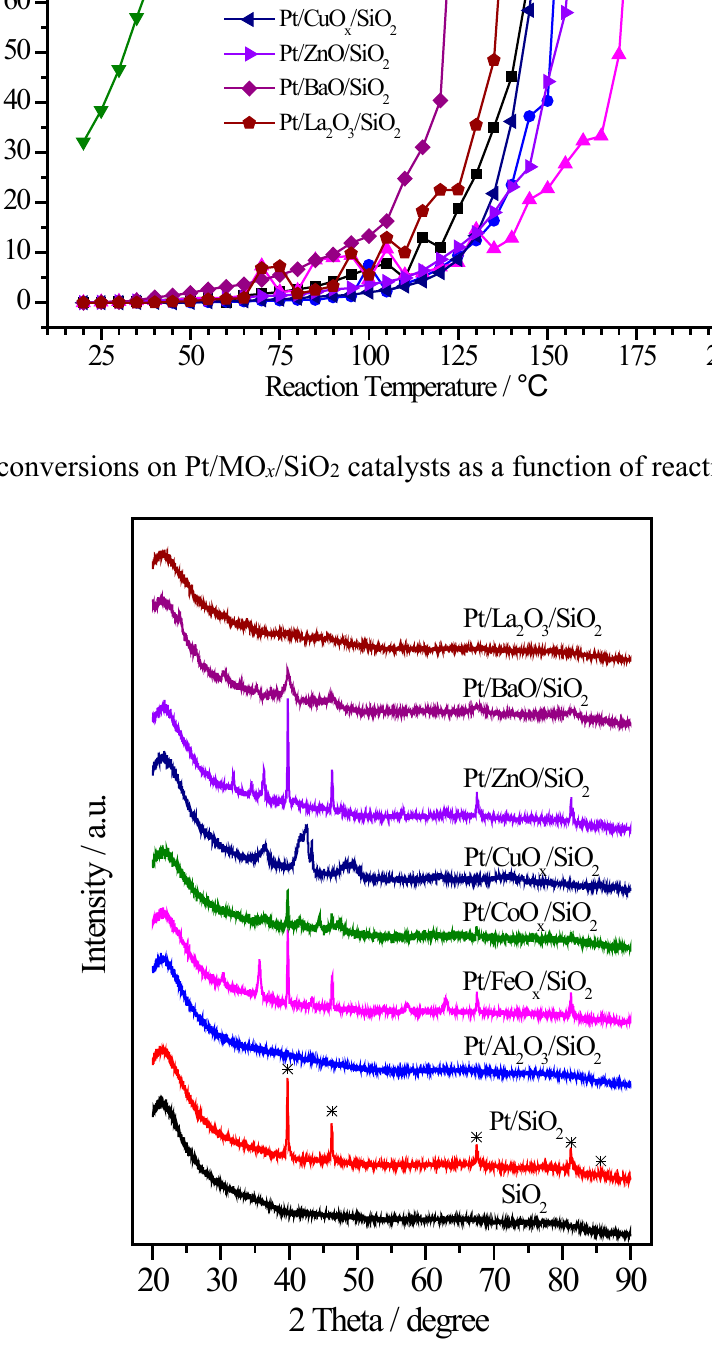
Figure 2. XRD patterns of Pt/MO x /SiO 2 catalysts collected after reaction testing. The XRD pattern of SiO 2 support is shown for comparison. (*: